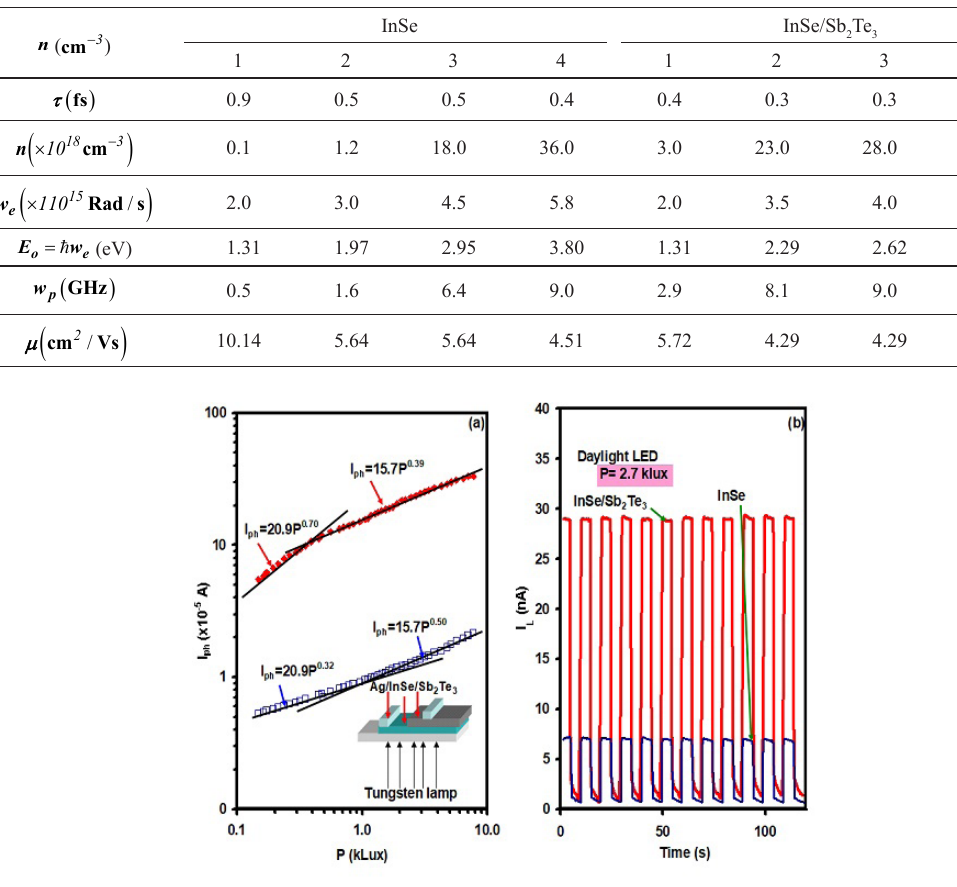
Table 2. Optical conductivity parameters for InSe and InSe/Sb